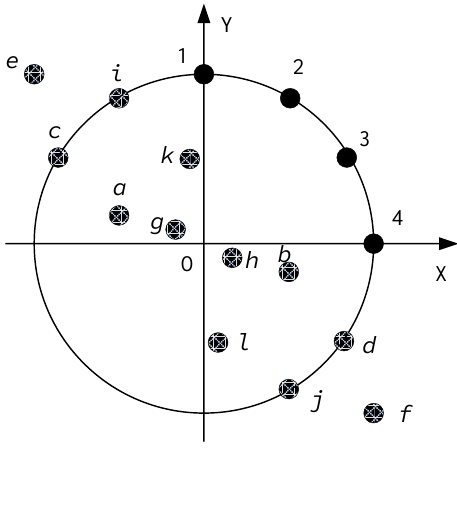
Figure 8. Positions of the expanded virtual elements. The black points represent the actual elements (1–4); and the shadow points represent the virtual elements (a −